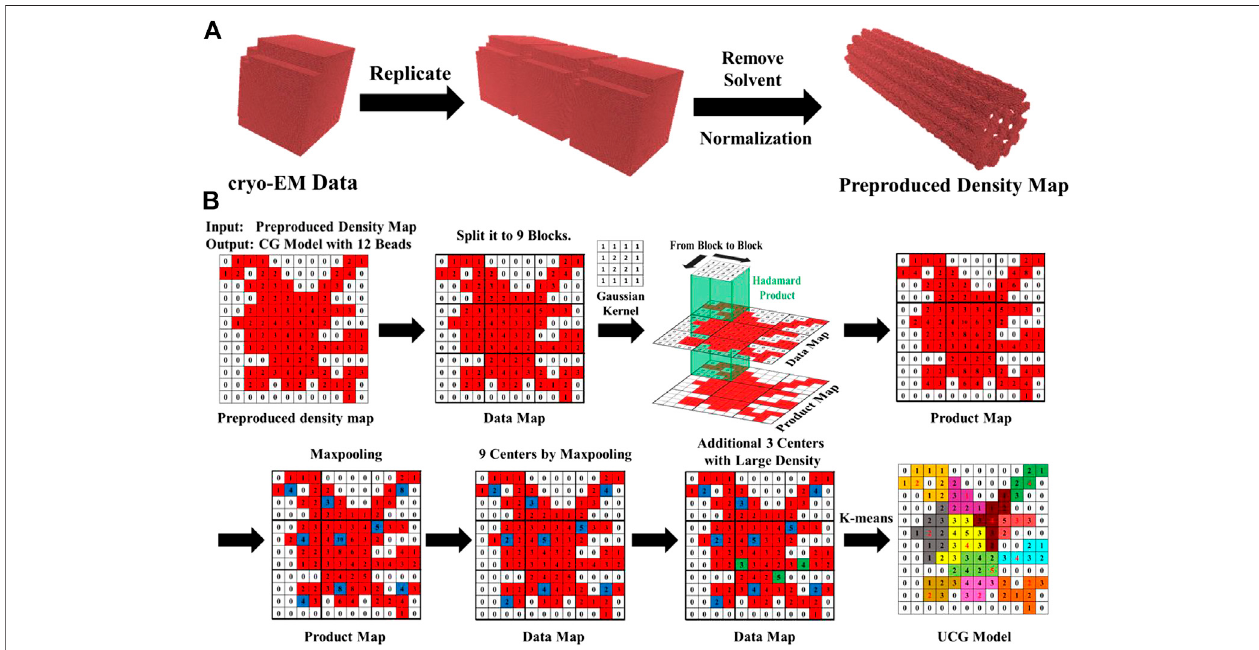
FIGURE1|(A) Thedatareprocessingincludesreplicatingthedensity,removingsolvent,andnormalizingdensity. (B) Theprocessofcoarse-grainingcryo-EMdata into12UCGbeadsusingtheCK-CGmethod.Thedensitymapis fi rstdividedinto9blocks.TheHadamardproductforeachblockisobtainedbyusingaGaussiankernel andthesubsequentmax-pooling generatestheinitialpositionsof9UCGbeads. Thepositionsoftheremaining3UCGbeadsaredetermined byothermaximaldensities in the blocks. Then, the 12 positions serve as the centers for clustering to yield the fi nal UCG beads.